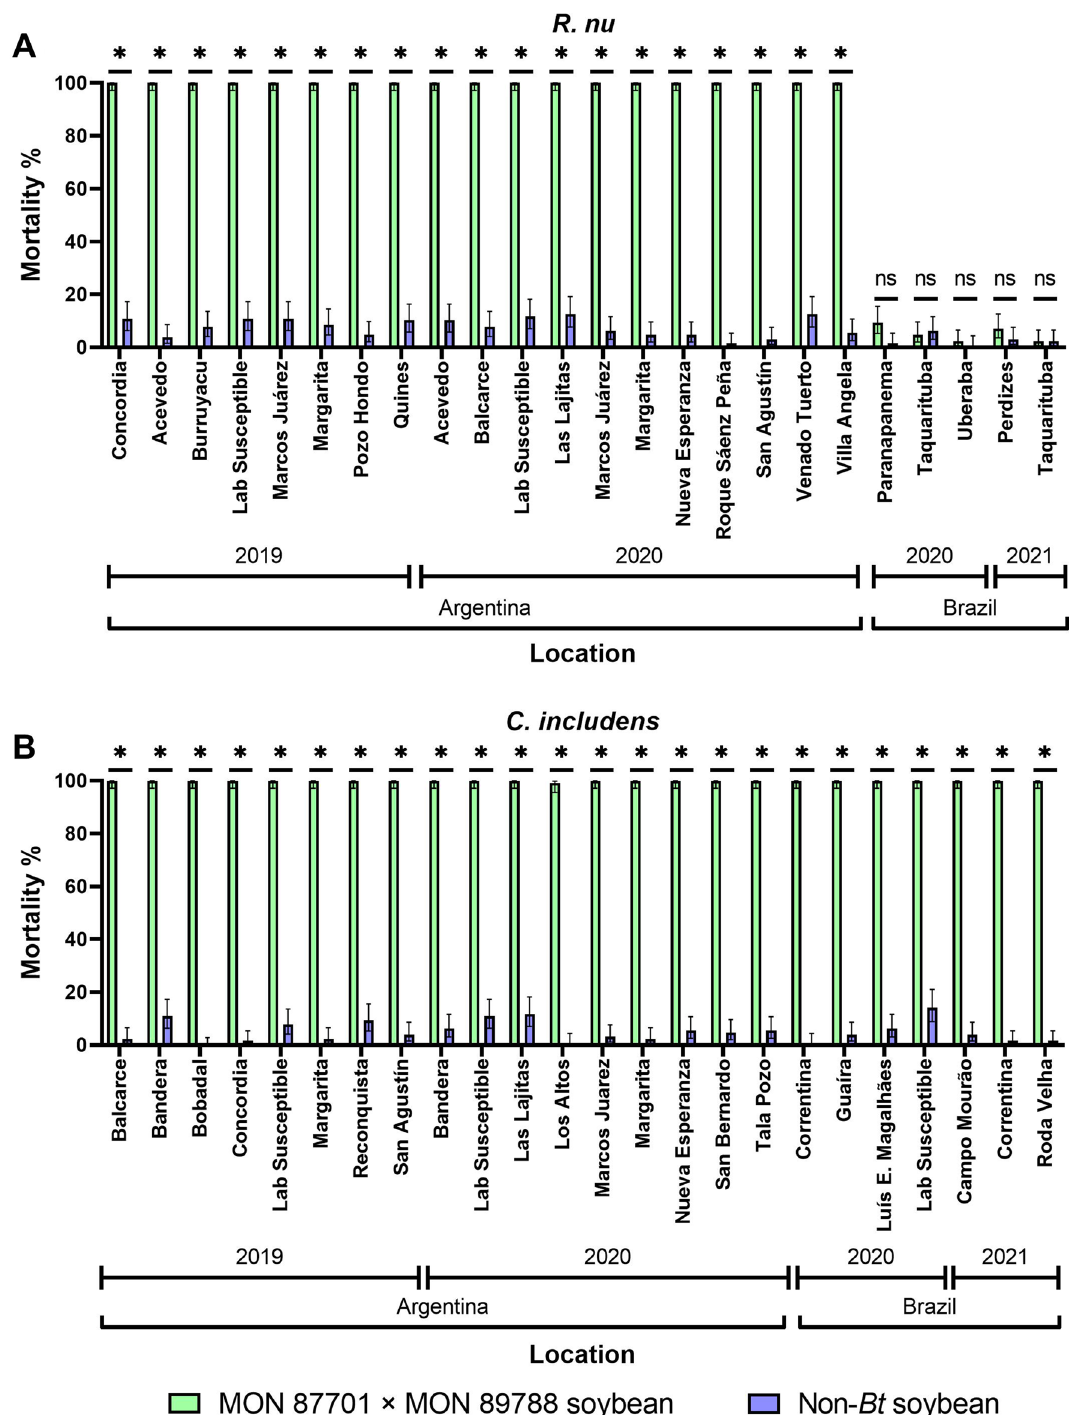
Figure 3. Mortality of R. nu ( A ) and C. includens ( B ) populations sampled from soybean fields in Argentina and Brazil on MON 87701 × MON 89788 soybean and non- Bt soybean. The asterisk (*) indicated that the mortality on MON 87701 × MON 89788 soybean and non- Bt soybean differed significantly due to non-overlap of 95% CIs. ns =